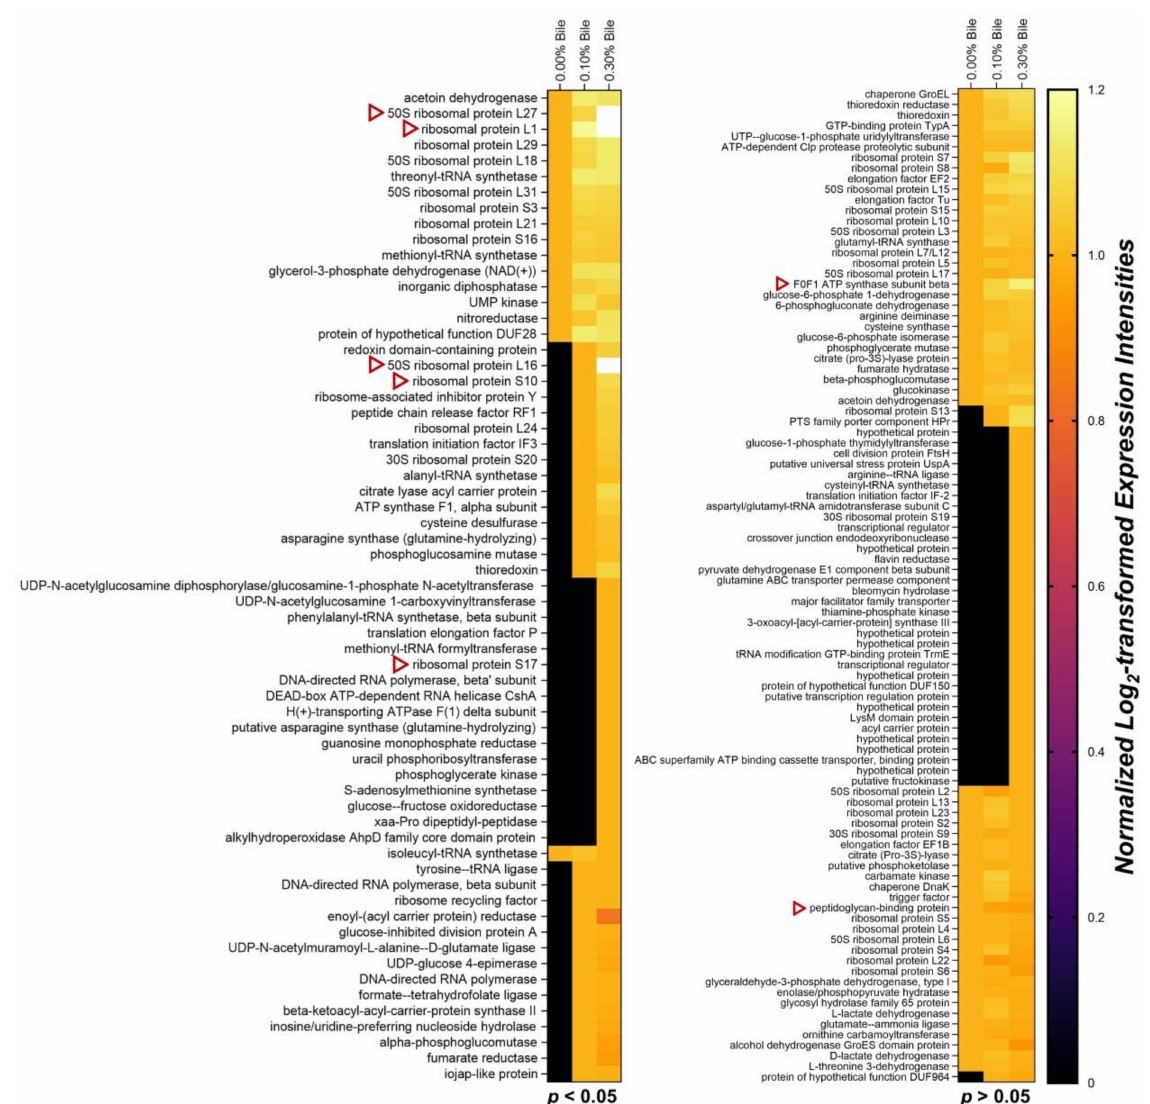
Figure 3. Abundance heatmap of the Lactobacillus mucosae LM1 exoproteome showing significant up or downregulation of secretion under bile stress ( p < 0.05), as well as proteins with no statistically significant changes in abundance ( p > 0.05). Red arrows indicate notable proteins with possible bile response